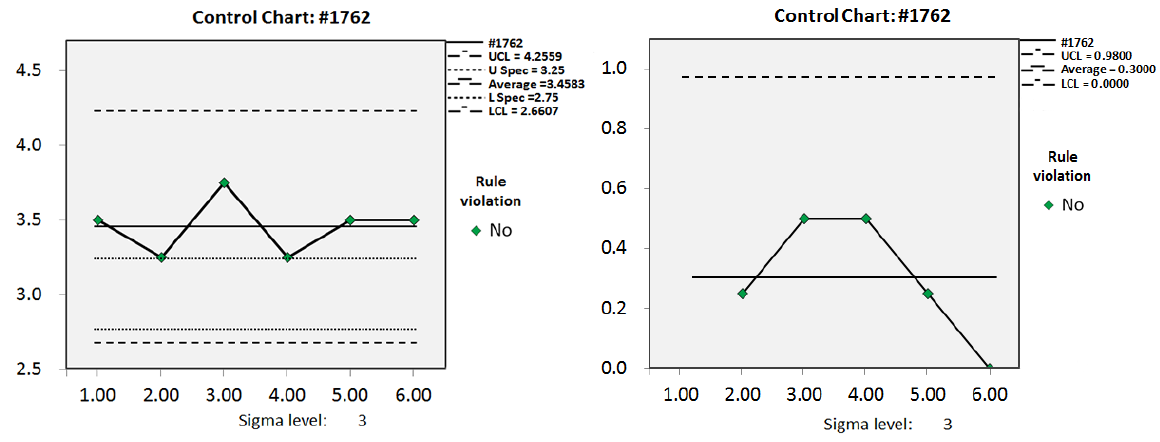
Figure 5. Control chart of BCS of cow 1762. Left : Course of individual BCS for 6 weeks. Right : BCS changes ( Δ